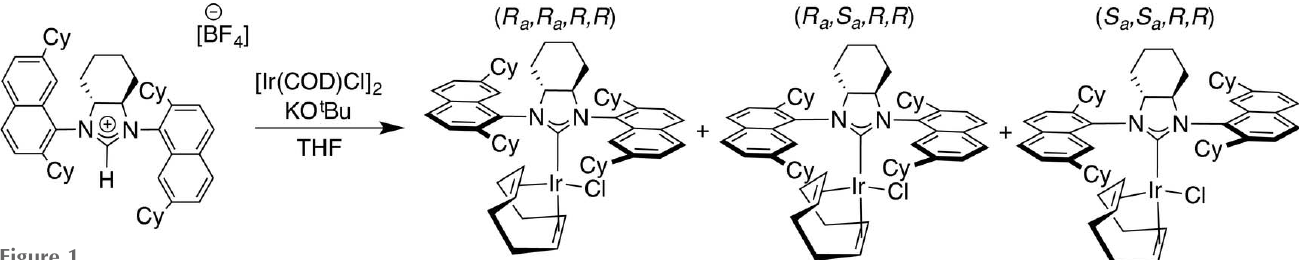
Figure 1 Reaction scheme for the synthesis of the title